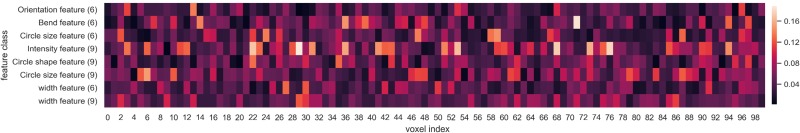
Heat map illustrating the relationship between voxels and specific interpretable features. The contribution of the specific voxels to the specific interpretable features is presented, which makes the voxel interpretable. Different colors are used to distinguish whether specific voxels are more active than others for specific image based features.